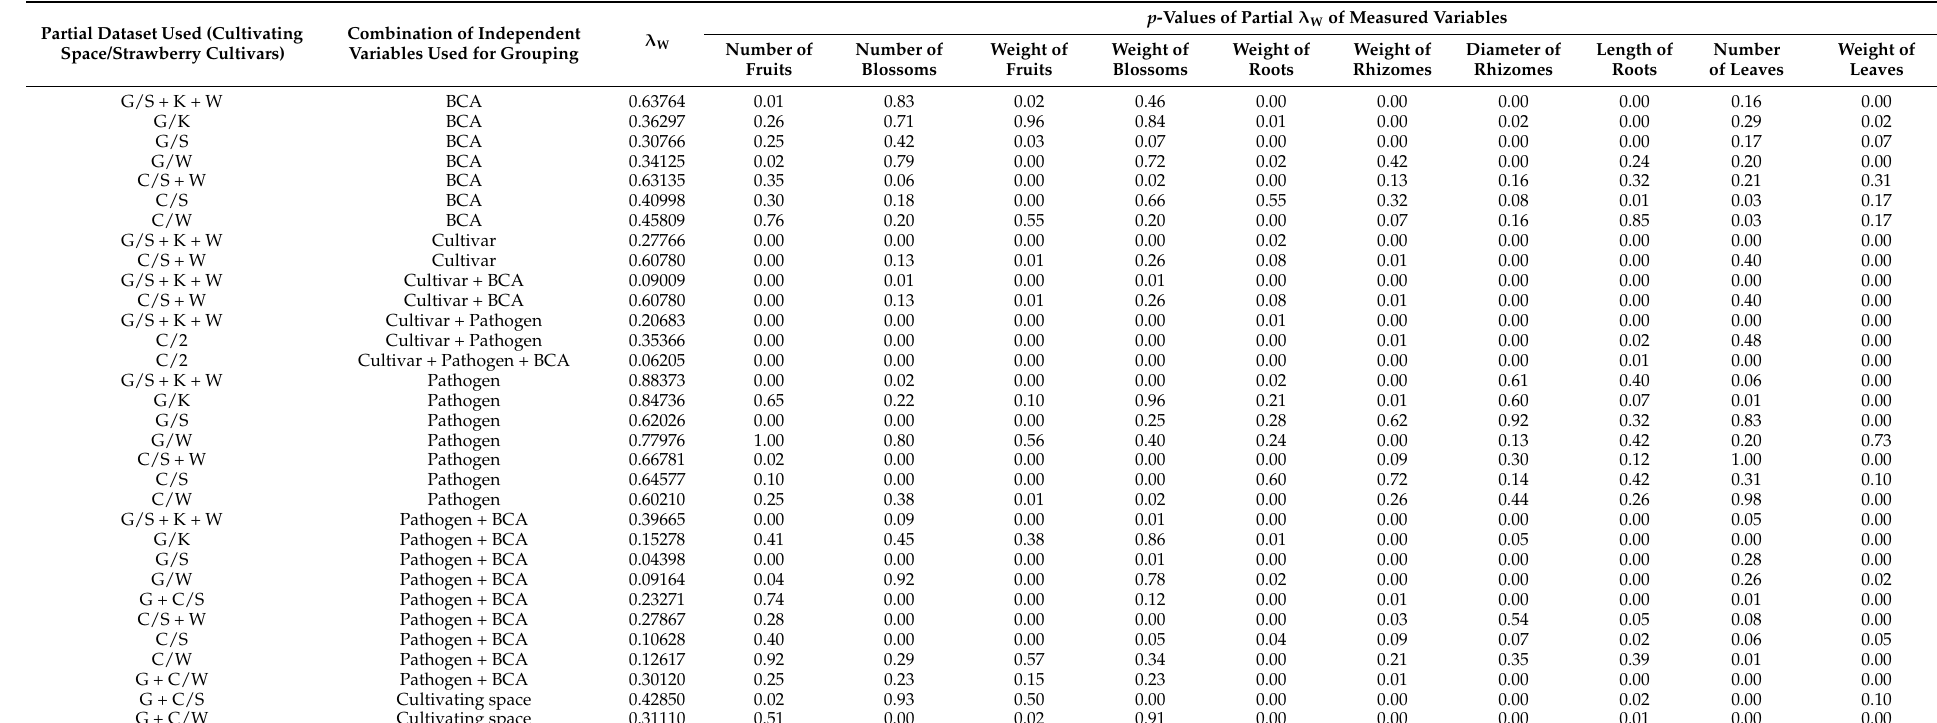
Table 3. The set-up and the results of discriminant